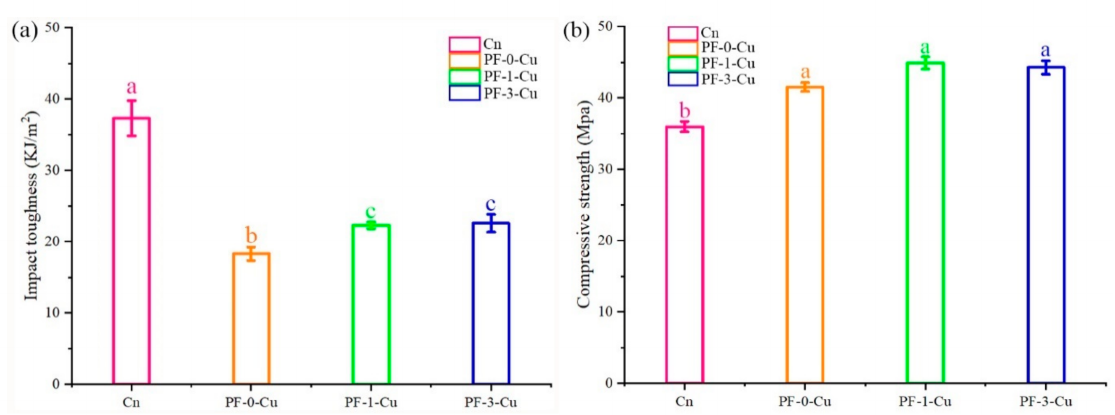
Figure 8. Mechanical properties of the control, PF-0-Cu, PF-1-Cu, and PF-3-Cu samples. ( a ) impact toughness, ( b ) compres- sive